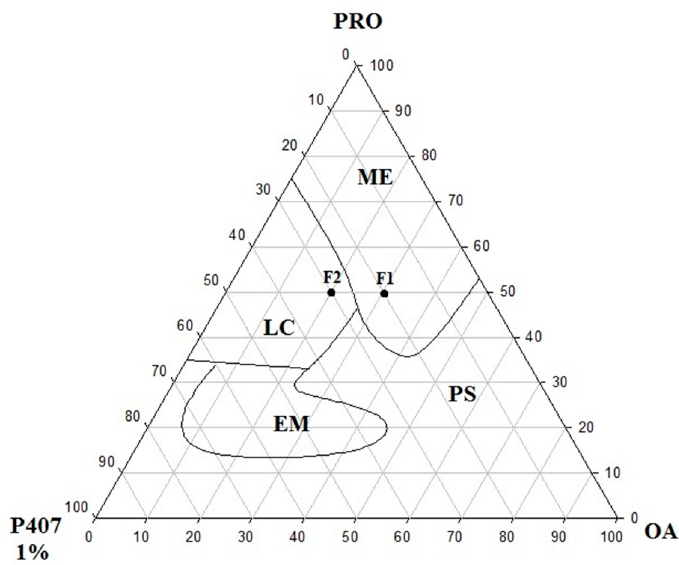
Figure 2. Ternary phase diagram of PPG-5-CETETH-20 (surfactant) with oleic acid (oil phase) and poloxamer 407 aqueous dispersion (1%). ME, microemulsion; LC, liquid crystal; EM, emulsion; PS, phase separation; PRO, PPG-5-CETETH-20 (Procetyl ® ); P407 1%, poloxamer 407 dispersion 1%; OA, oleic acid.